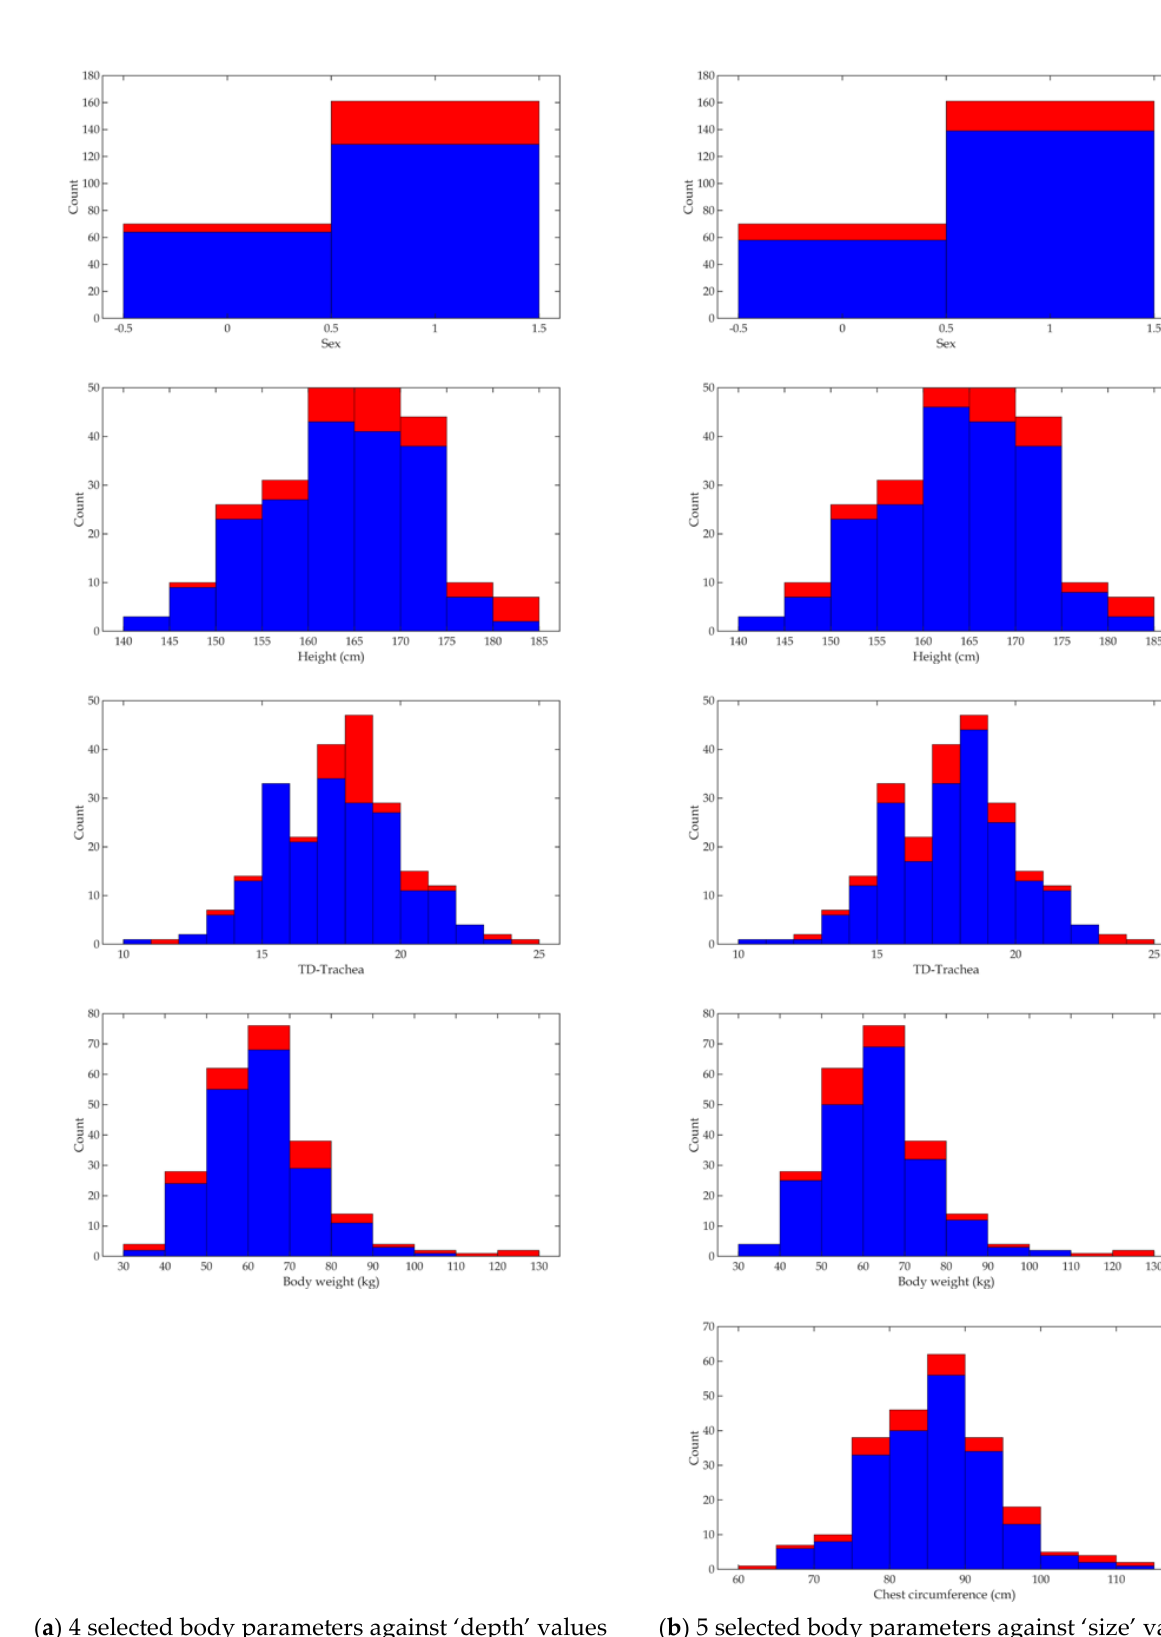
Figure 7. Histograms showing data distributions for four or five selected body parameters against ‘depth’ or ‘size’ values, those after outlier rejection (in blue) and outliers (in red). Note in proportion, more values on both ends of the distributions were rejected.